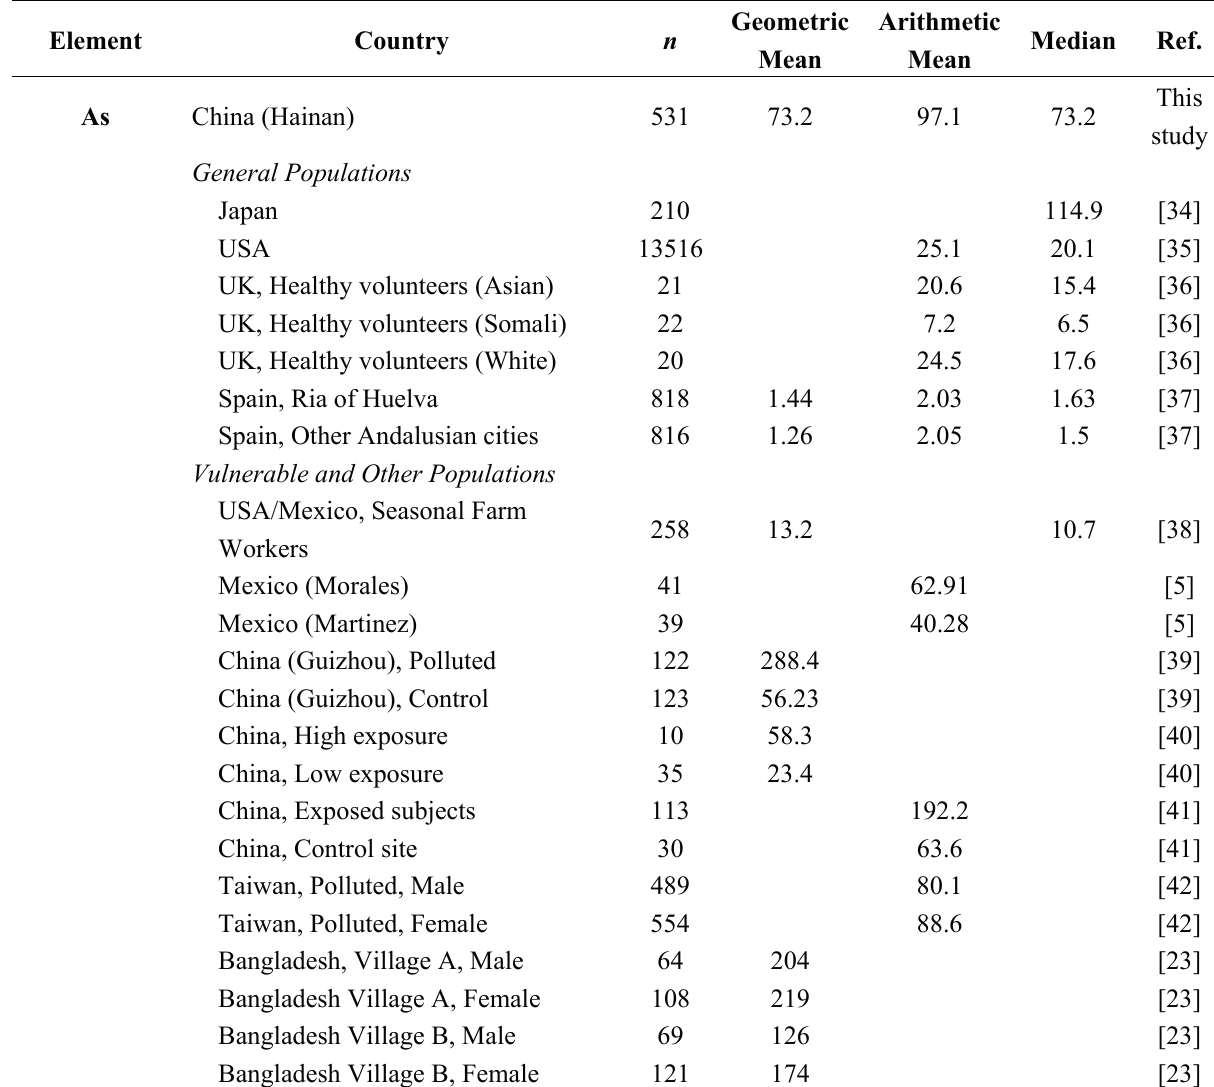
Table 5. Comparison of means, medians, and selected percentiles of urinary concentrations of toxic and trace elements ( μ g/g creatinine) from previous studies with those from rural residents in Hainan Province, China (present